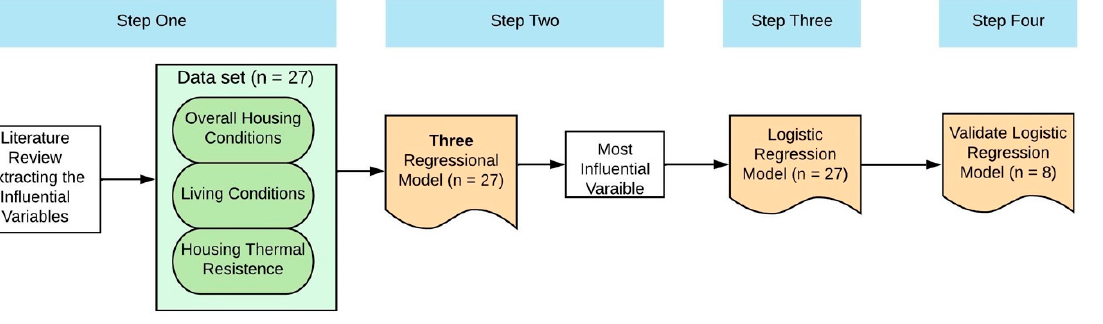
Figure 1. Research